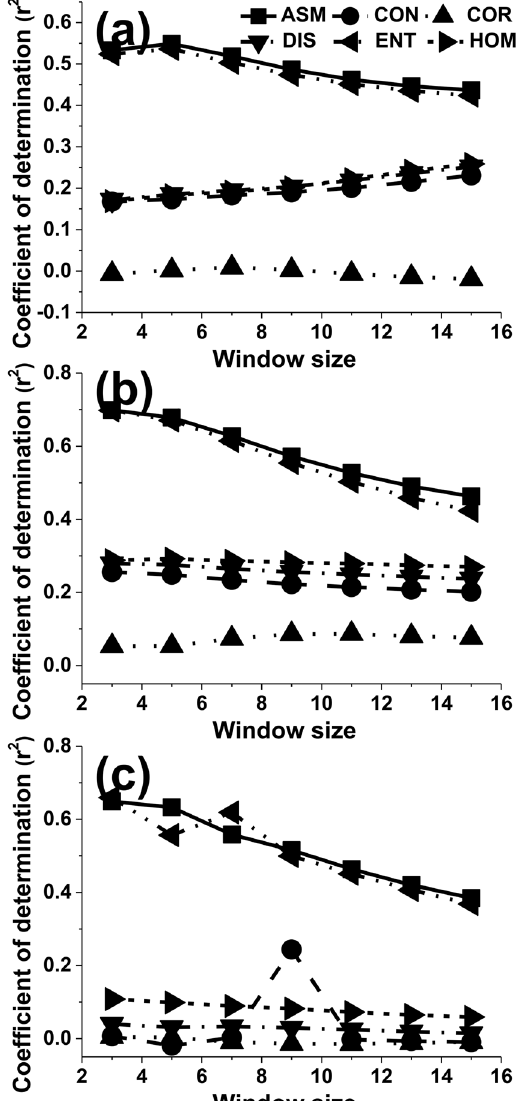
Figure 5. The effect of the window size on the values of adjusted r 2 for different texture features when the orientation was set to 45° and the displacement was set to 5 pixels ( a ); when the orientation was set to 135° and the displacement was set to 5 pixels ( b ); when the orientation was set to 135° and the displacement was set to 15 pixels ( c